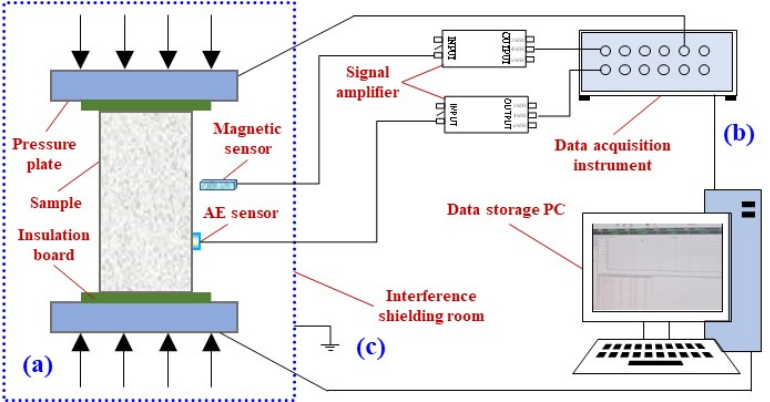
Figure 1. Experimental system diagram. ( a ) Loading system; ( b ) Data acquisition system; ( c ) Elec ‐ tromagnetic shielding